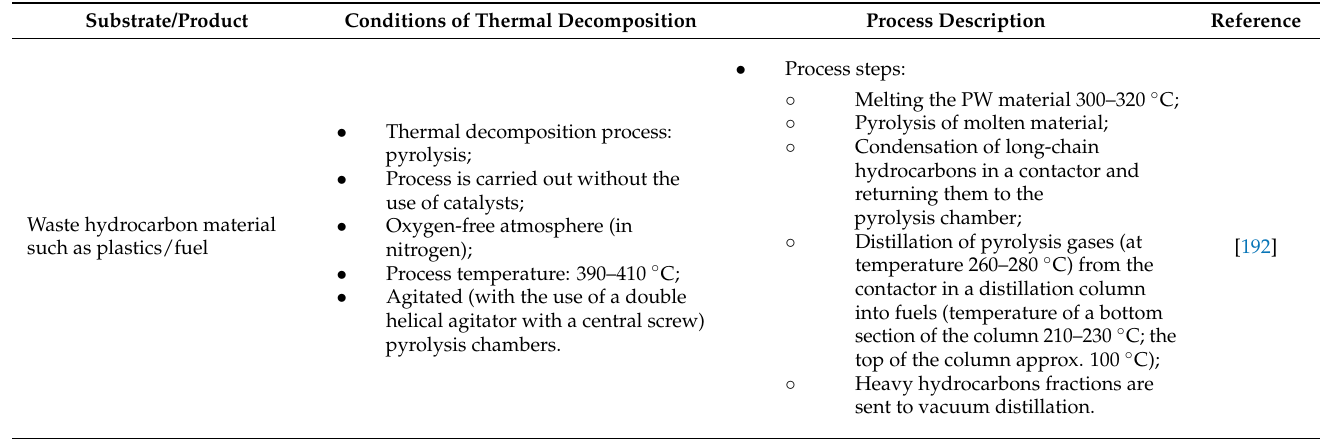
Table 6. Comparison of different patented processes for the conversion of PW to hydrocarbon fractions. Substrate/Product Conditions of Thermal